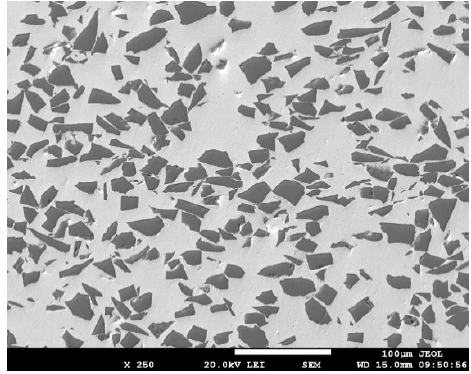
Figure 2. Microstructure of a metal–ceramic composite of the type Cu–SiC.